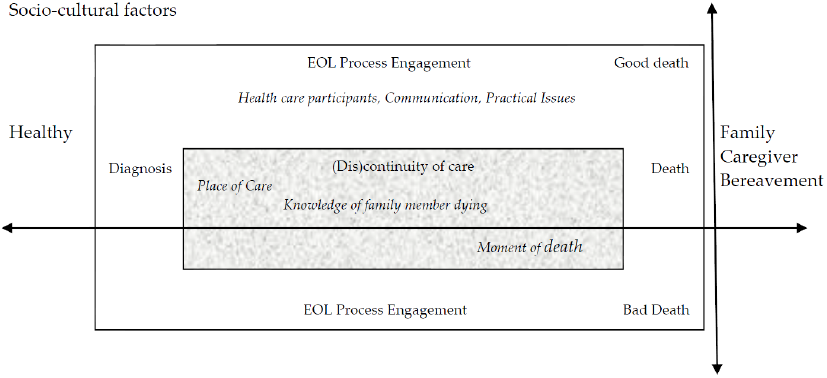
Figure 2. The Opportunity Model for Presence during the EOL Process.